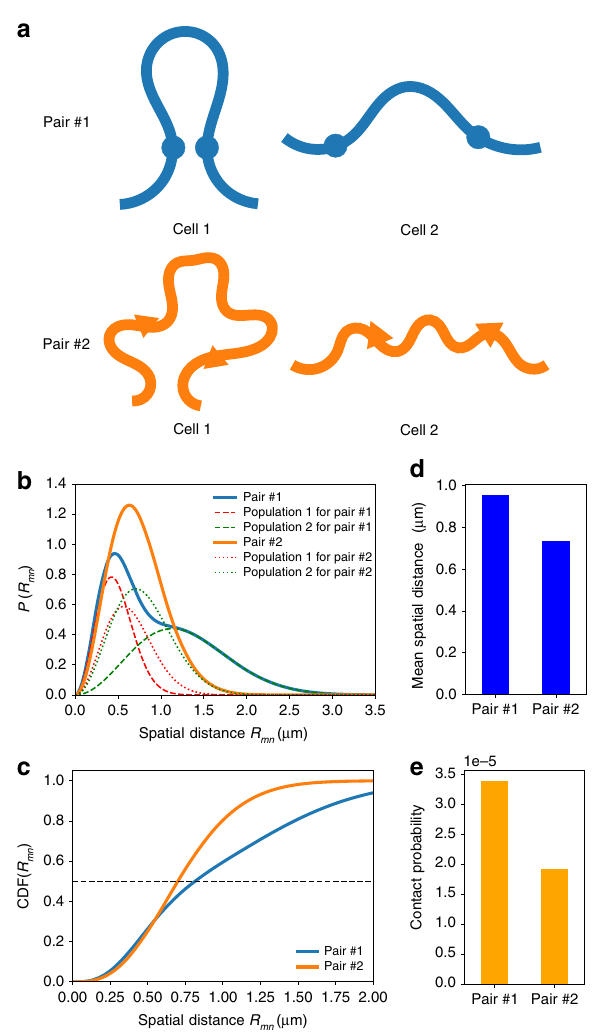
Fig. 2 Illustrating the FISH – Hi-C ([ P mn , 〈 R mn 〉 ]) paradox. a Schematic illustration of the populations of two cells. There are two pairs of loci, pair 1 and pair 2. Cells 1 and 2 belong to two distinct populations such that pair 1 and pair 2 have different distributions of distances in the two cells. Pair 1 is always in proximity (contact is formed) in cell 1, whereas it is spatially separated (mean distance > r c ) in cell 2. Pair 2, on the other hand, has similar distributions of spatial distance in cells 1 and 2. Cell with two different populations gives rise to paradoxical behavior, which is illustrated by choosing η 1 = 0.4 and η 2 = 1 − η 1 = 0.6. These are the probabilities for a cell belonging to population 1 and 2, respectively. The pair 1 has parameters σ = 0.3 μ m and σ = 0.8 μ m. The pair 2 has parameters σ = 0.4 μ m and 1 2 1 σ = 0.5 μ m. See Eq. (2) for the de fi nition of σ σ 2 1 and 2 . b The distribution of distance for pair 1 (thick blue) and pair 2 (thick orange), respectively. The distributions for the two different populations are shown separately for pair 1 (dashed lines) and pair 2 (dotted lines). c Cumulative distribution of the spatial distance. The horizontal dashed line indicates the median distance. d Mean distances for pair 1 is larger than for pair 2. e Pair 1 has larger contact probability than 2, which is paradoxical since the distance between the loci in pair 1 is larger than in 2. The threshold for determining contact is r c = 20